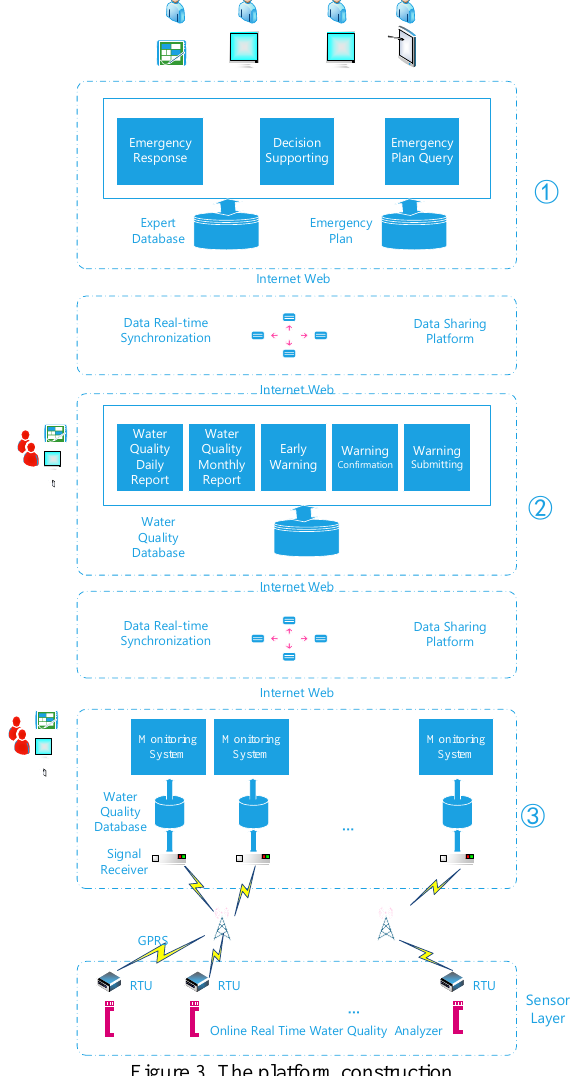
Figure 3. The platform construction